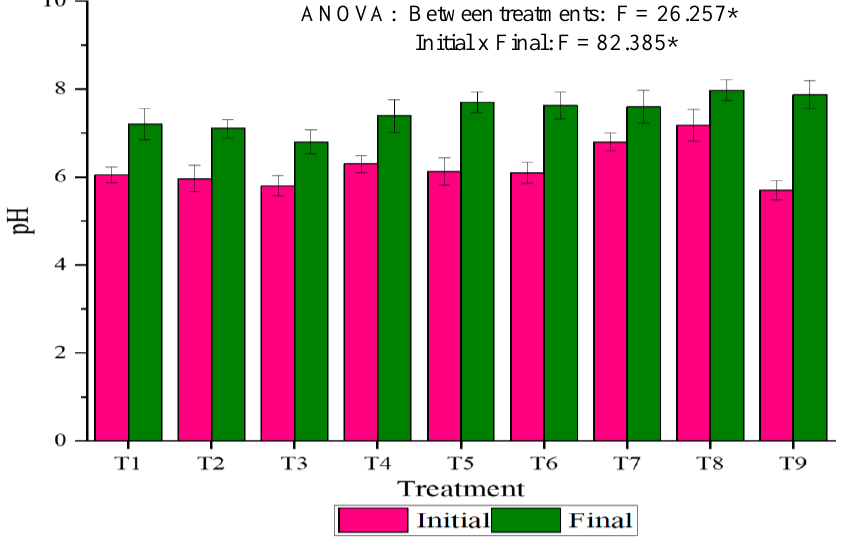
Figure 2. Dynamics of pH among various composting treatment groups. ‘*’ indicates a significant difference at p < 0.05 by ANOVA.